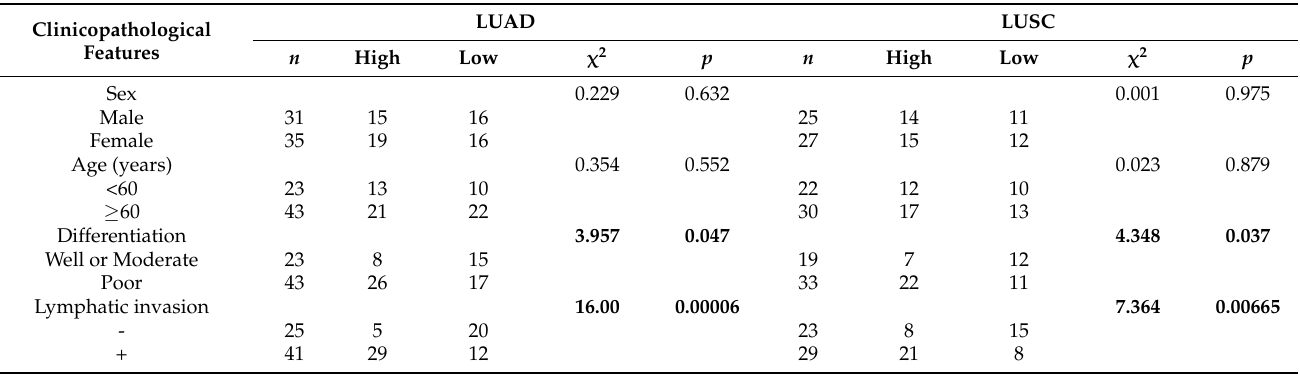
Figure 7. Serum SLC3A2 in LUAD and LUSC patients. ( A ) SLC3A2 serum levels from the LUAD and LUSC patients and healthy controls were detected using ELISA. ROC curve analysis for SLC3A2 diagnosis in the patients with LUAD ( B ) and LUSC ( C ). Kaplan–Meier curves of the cumulative survival rate of the patients with LUAD ( D ) and LUSC ( E ) based on their SLC3A2 serum levels. Table 1. Relationships between serum SLC3A2 and the clinicopathological parameters of patients with LUAD or LUSC.